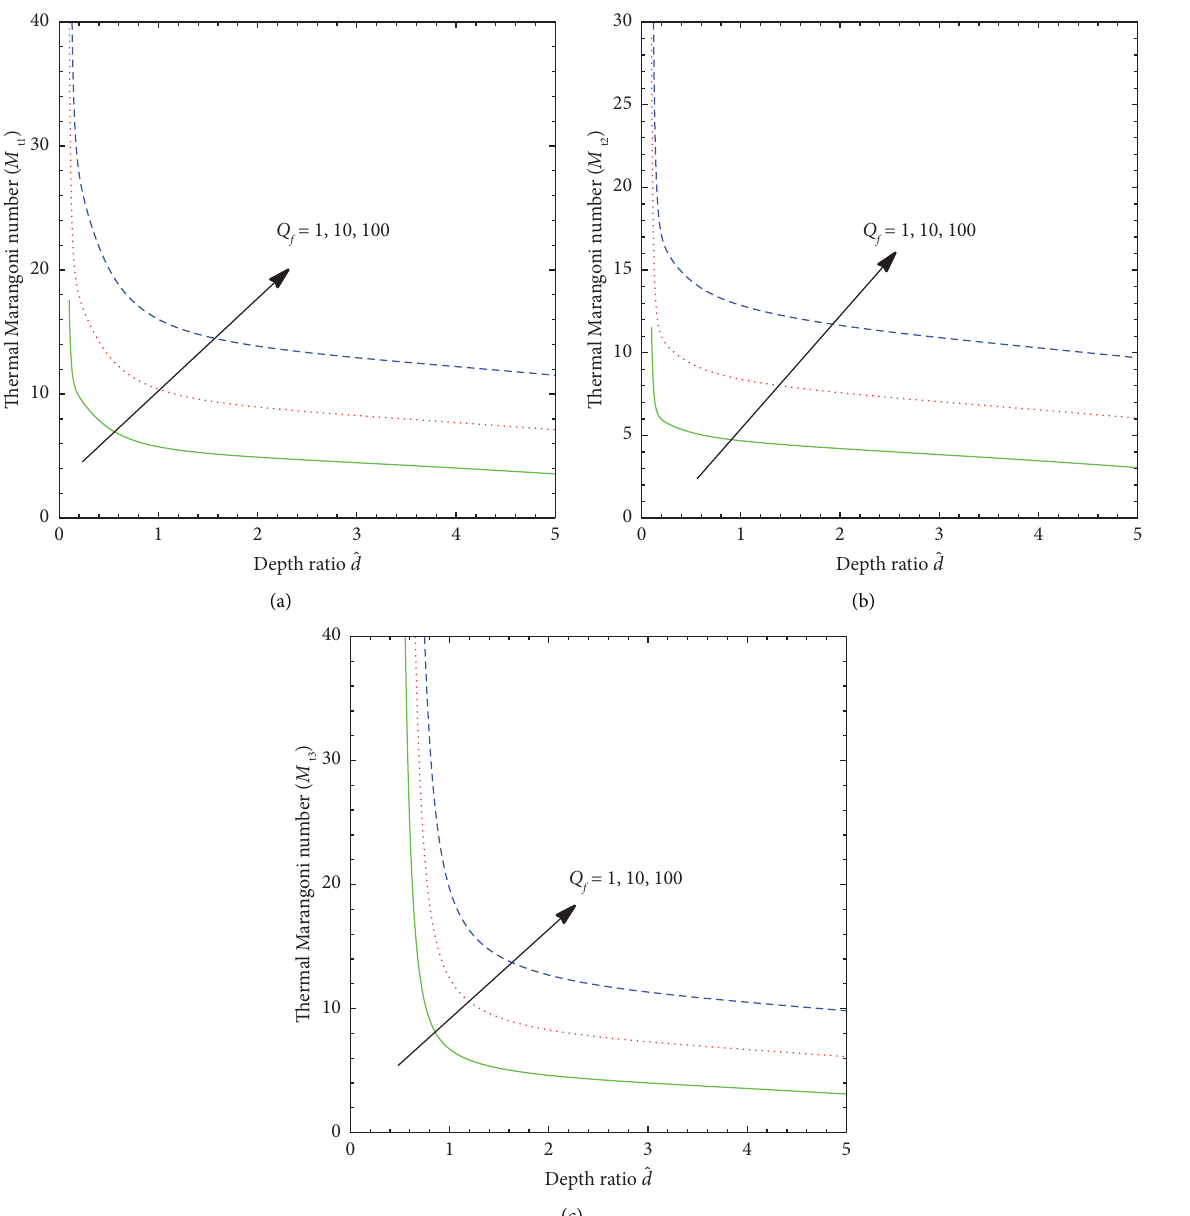
Figure 2: TeinfuenceofChandrasekhar’snumber Q M � S